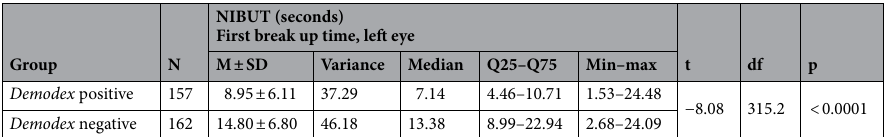
NIBUT (seconds) First break up time, left eye